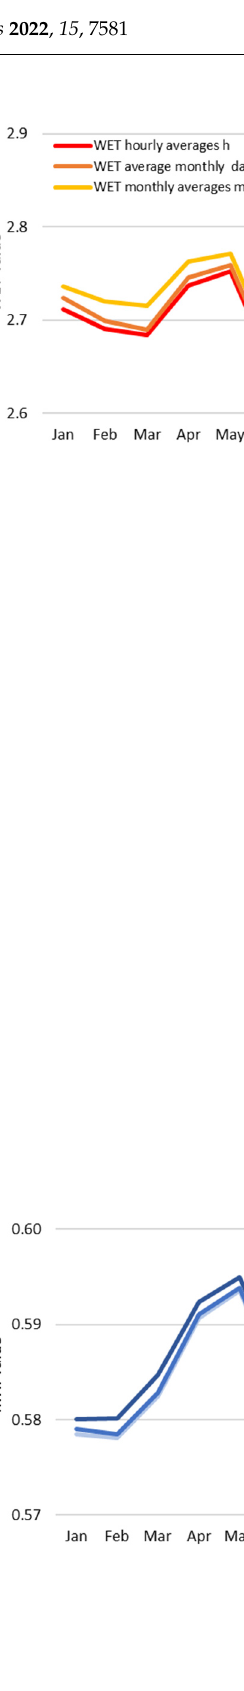
13 of 25 Figure 7. S ingapore, t and r.h. during the average year. It can be observed that: •